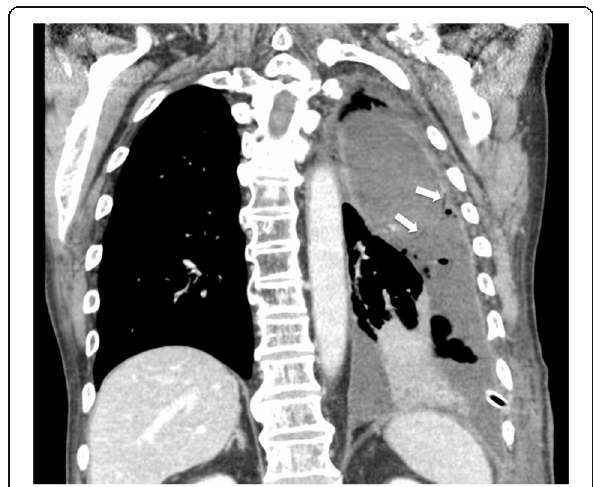
Fig. 3 Preoperative chest computed tomography showing poor lung re-expansion, loculated pleural effusions, and a residual extrapleural hematoma with extrapleural fat signal (white arrow) after placement of the second chest tube